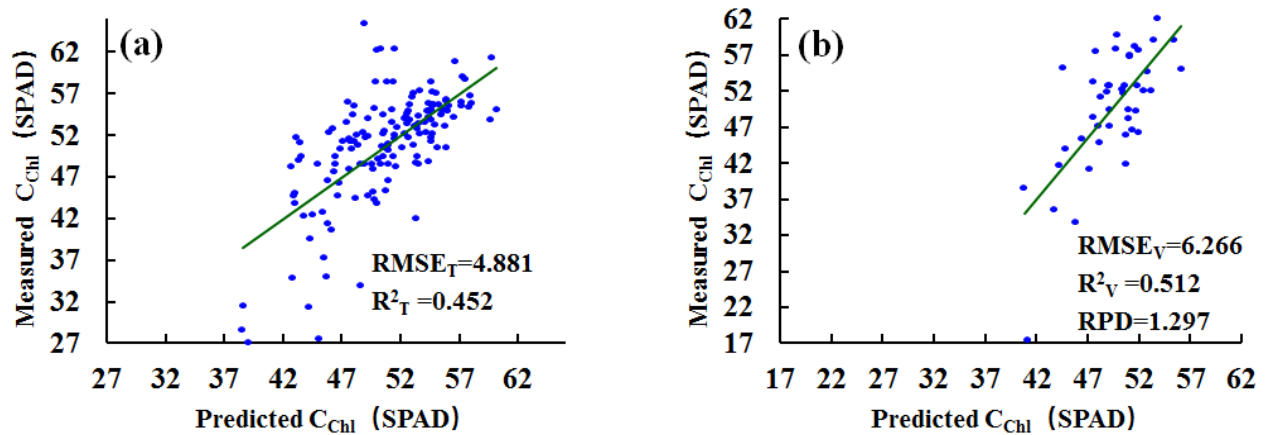
Figure 13. The estimated results of SPAD value for ( a ) training set and ( b ) validation set based on pretreatment ND-(1/R)’-PCADR at filling stage.